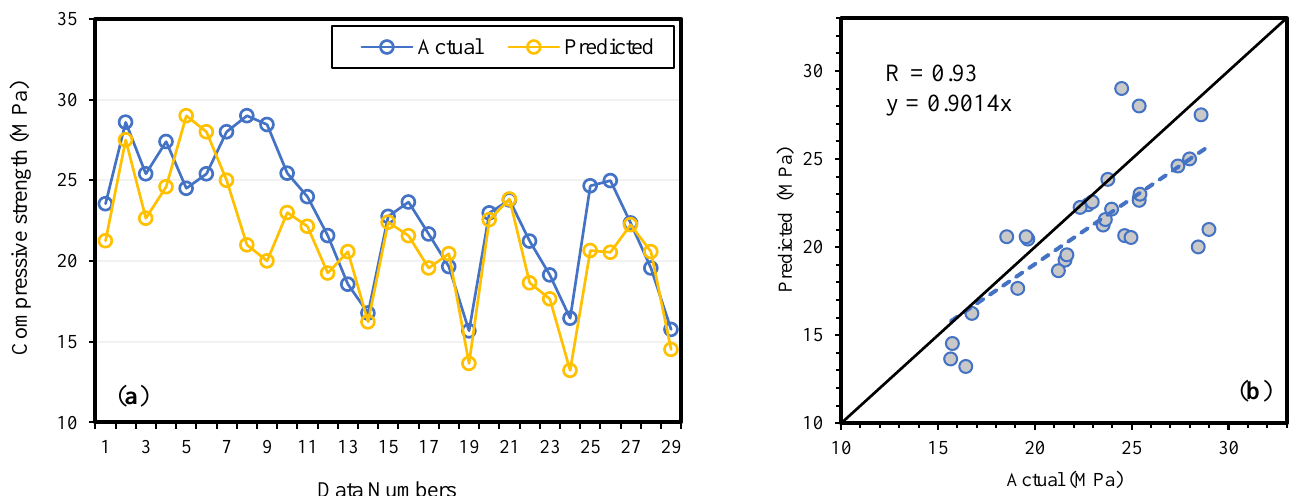
Figure 6. Compressive strength ( f c′ ) model validation by experimental results ( a ) variation in data ( b ) scattered plot.